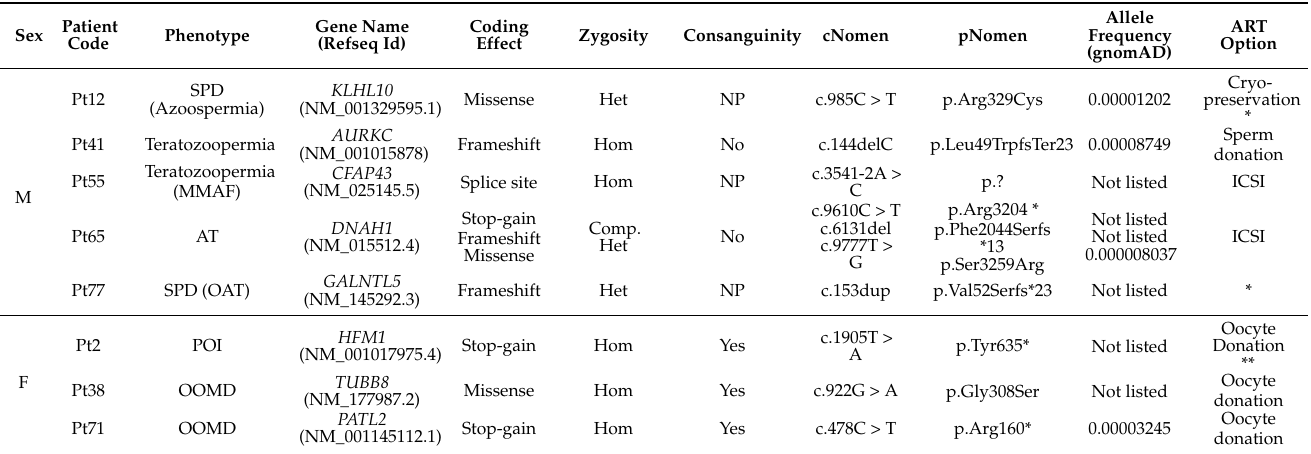
Table 4. Identified mutations according to phenotype and sex of the